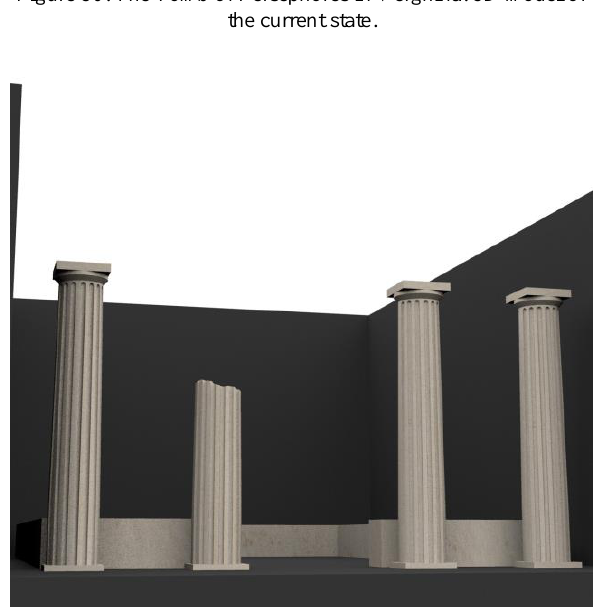
Figure 31. The Tomb of Persephores in Verghina. View from the west. Detail of the 3D